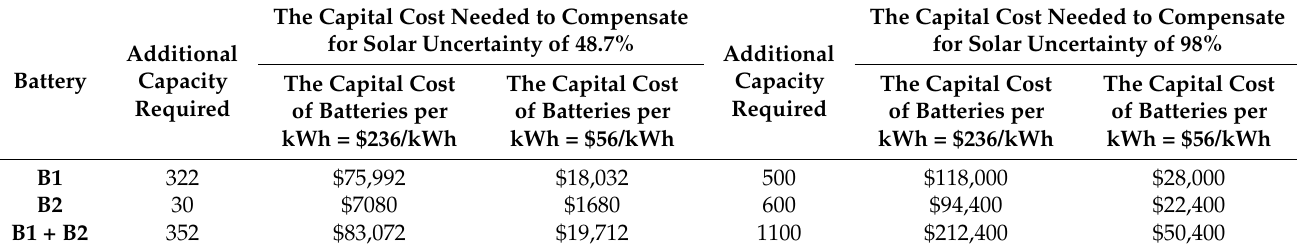
Table 5. Costs for including additional energy storage capacity to compensate for solar generation uncertainty.